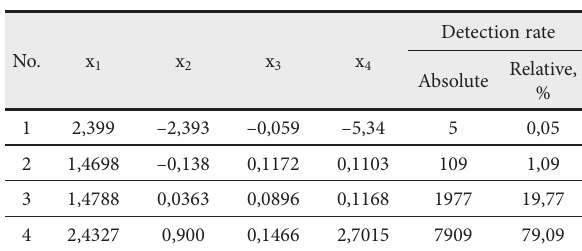
The roots of the system of equations of the condensation telomerization model at K 1 =K 2 =10. Initial